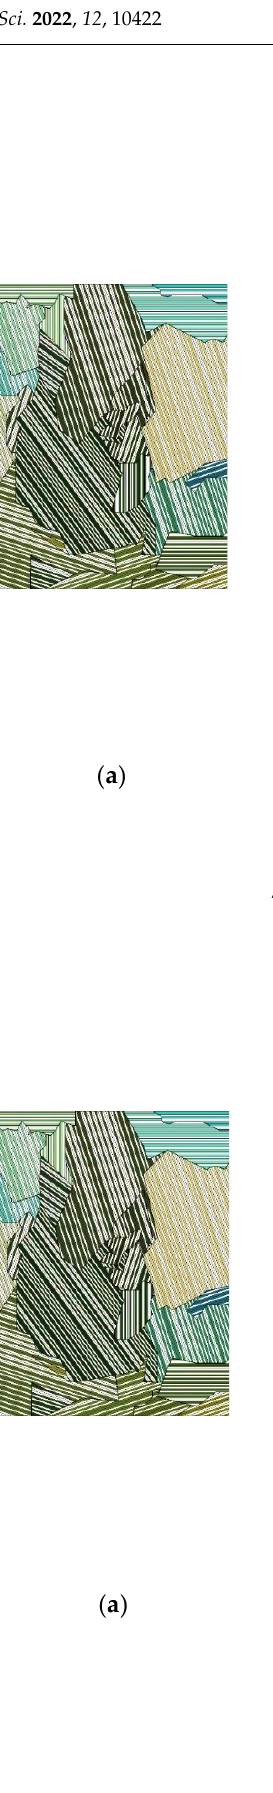
( b ) Figure 19. A second illustration of extracting the secret message from the stego-image using the right secret key. ( a ) The stego-image with the stripe widths of 6 pixels shown in Figure 15e. ( b ) The correct result “Actions speak louder than words.” of hidden data extraction using the secret key “Action”.